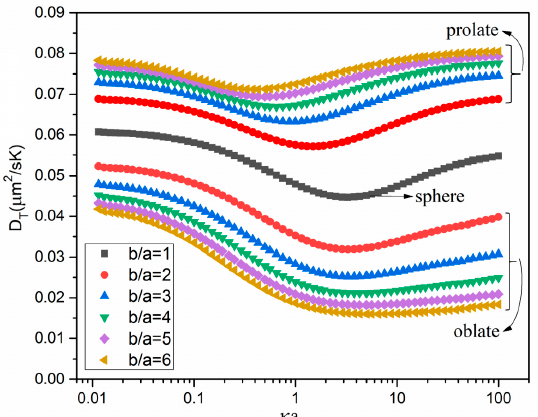
D on the ratio T T for six 0